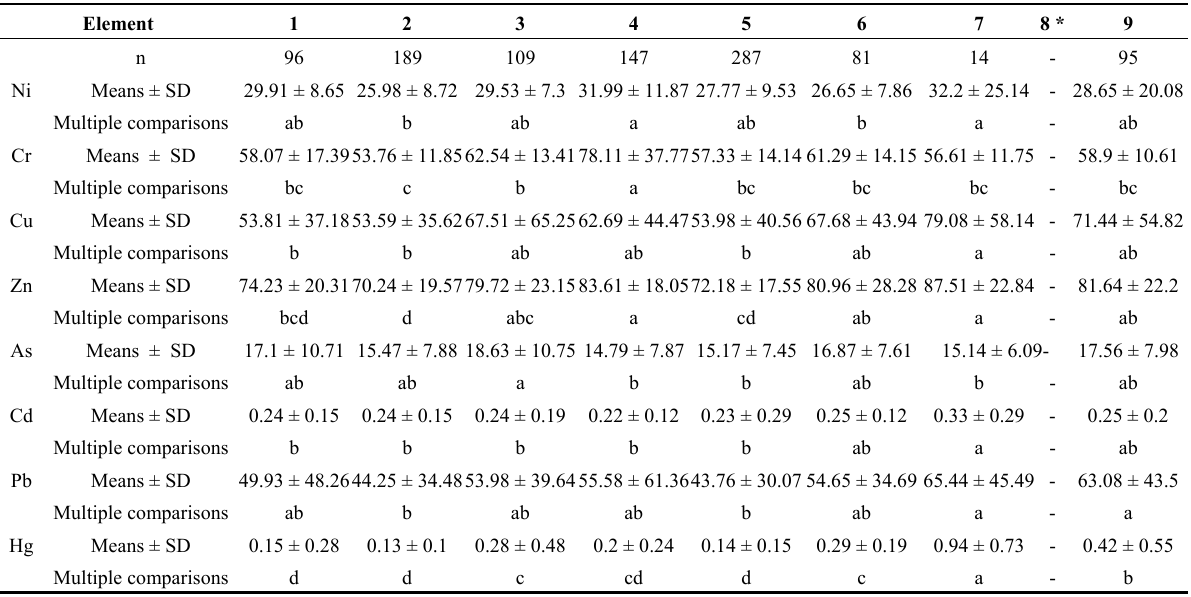
Table 6. Concentrations and multiple comparisons of heavy metals of different clusters (milligrams per